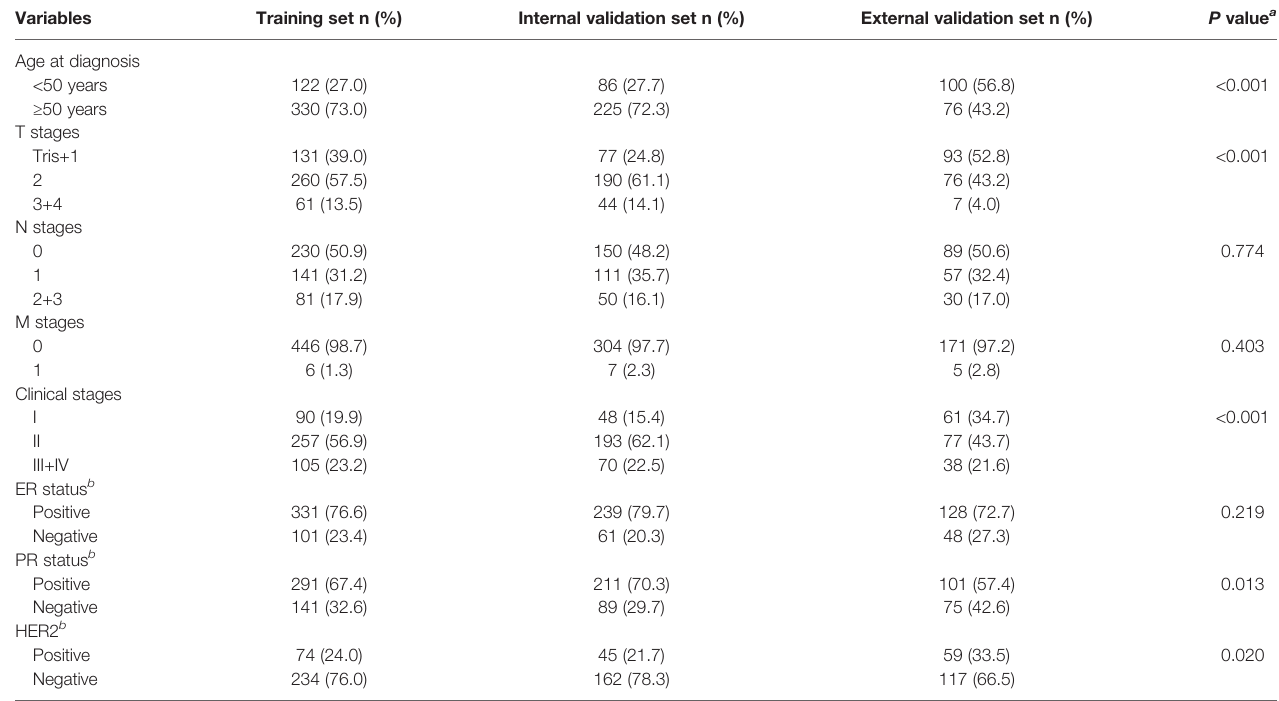
TABLE 1 | Frequency distributions of clinicopathological features of BRCA